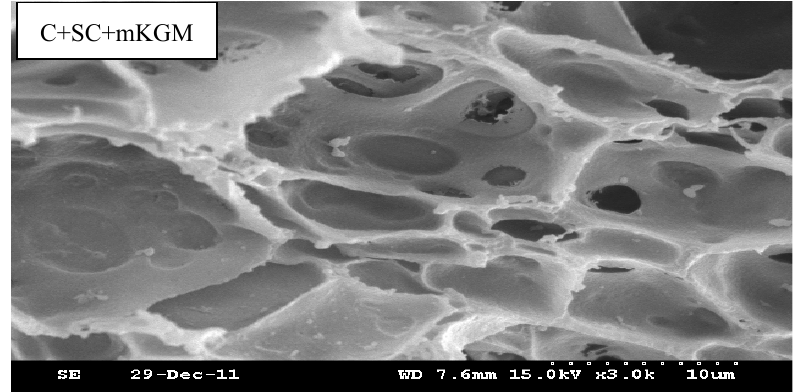
Figure 7. SEM micrographs (3000×) of 500 MPa HP+H rabbit myosin protein gels.